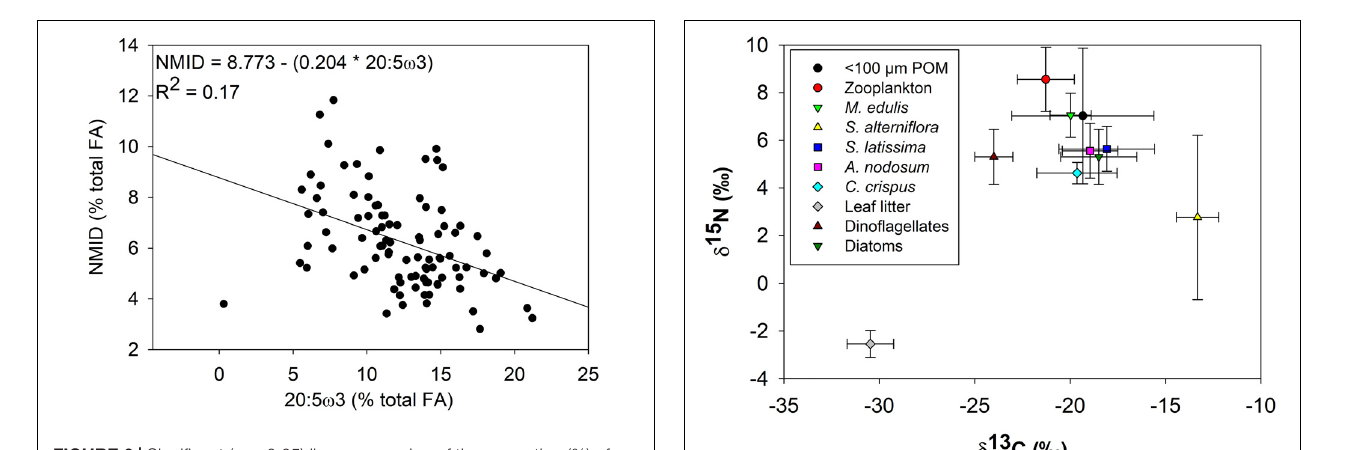
TABLE 3 | Proportion (%) of endmember fatty acids in Mytilus edulis collected from Saco Bay, ME, United States, throughout 2016 and 2017. Endmembers: Zooplankton (20:1 and 21:1), Vascular plants (18:2 ω 6 and 18:3 ω 3), Macroalgae (18:1 ω 9, 18:3 ω 6, 20:2 ω 6, 20:4 ω 3, and 20:4 ω 6), Diatoms (16:1 ω 7, 16:4 ω 1 and